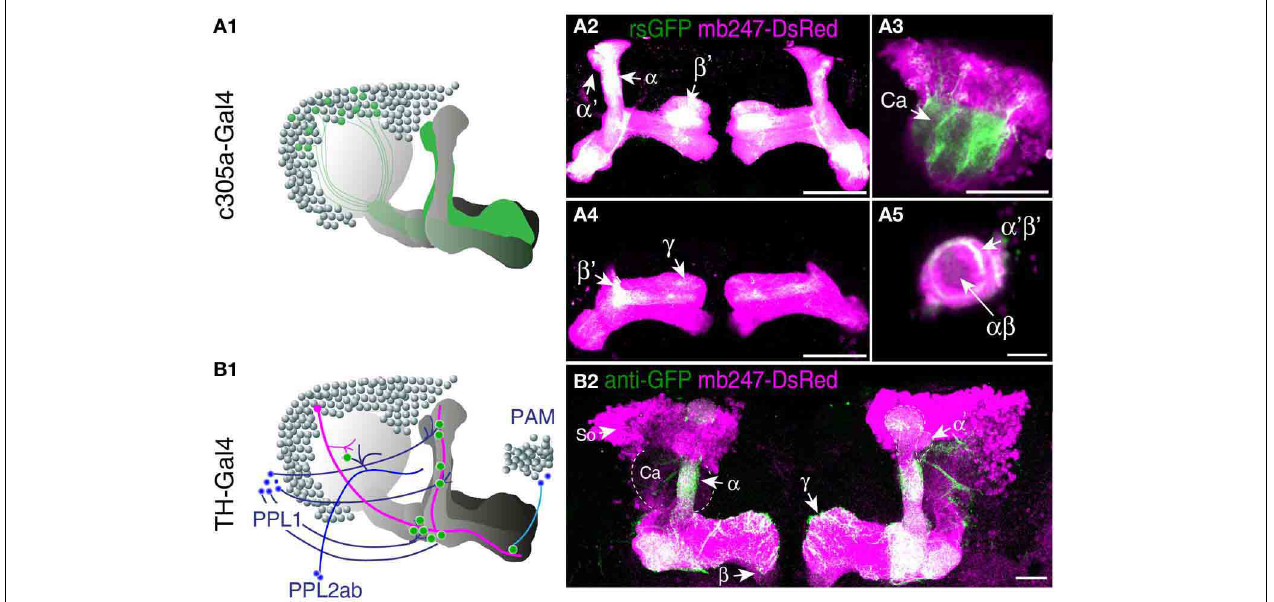
green. (B) Theflystrainmb247-DsRed;mb247-splitGFP11,UAS-splitGFP1-10is crossed with TH-Gal4. The offspring shows reconstituted splitGFP fluorescence at contact regions of close proximity between populations of dopaminergicneuronsandKenyoncells,inadditiontotheDsRedfluorescence. (B1) Schematic illustration of the splitGFP reconstitution between populations of intrinsic mushroom body neurons and dopaminergic neurons from the PAM cluster, PPL1 cluster, and PPL2ab cluster of dopaminergic neurons. (B2) Reconstituted splitGFP fluorescence between dopaminergic neurons and Kenyon cells indicates contacts of dopaminergic neurons predominantly in the α -and γ -lobesandtheheelofthehorizontallobes.Mb247-DsRedfluorescence is shown in magenta and the reconstituted splitGFP labeled by anti-GFP in green. Ca, calyx; So, somata; Scale bars = 10 μ m in (A5) , 40 μ m